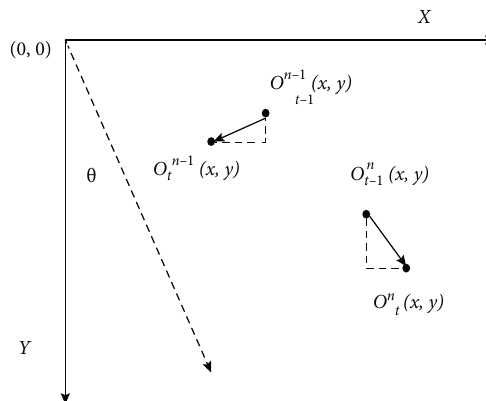
Figure 5: The calculation principle of target movement direction θ .